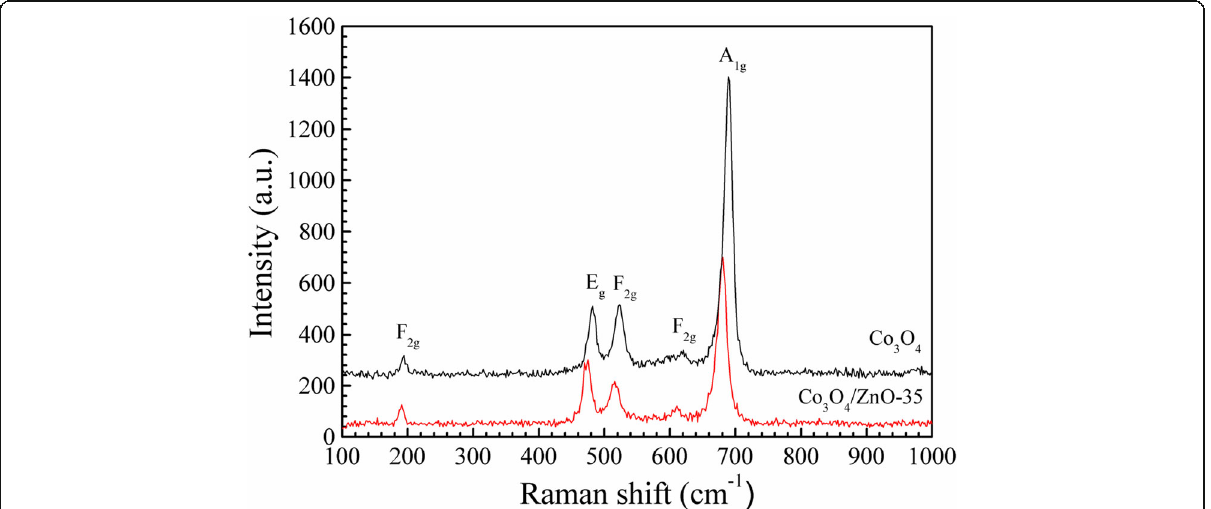
Fig. 3 Raman spectra of pure Co 3 O 4 and Co 3 O 4 /ZnO-35 heterostructure